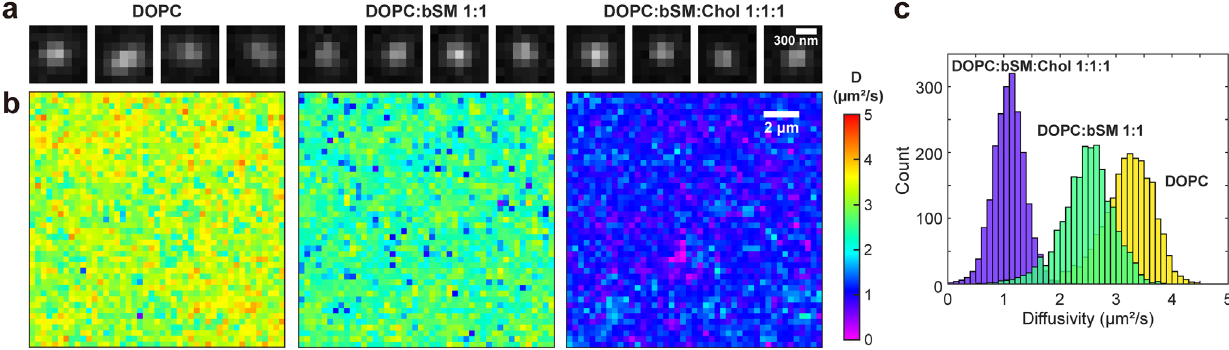
Fig. 3 Pix2D applied to experimental data on single molecules diffusing in supported lipid bilayers (SLBs). a Example wide- fi eld single-molecule images collected at an exposure time of 9 ms per frame, for BDP-TMR-alkyne diffusing in SLBs of different compositions: DOPC only, DOPC:bSM 1:1 (mol%), and DOPC:bSM:cholesterol 1:1:1 (mol%). b Color-coded D maps of the three samples generated by spatially binning the single-molecule images accumulated over 30,000 frames onto a 320 nm × 320 nm grid, and then feeding the resultant ~200 single-molecule images in each bin into the Pix2D CNN for evaluation of local D . c Distributions of the evaluated D- values in each bin for the three samples, corresponding to 3.21 ± 0.45, 2.48 ± 0.46, and 1.09 ± 0.28 µ m 2 /s,